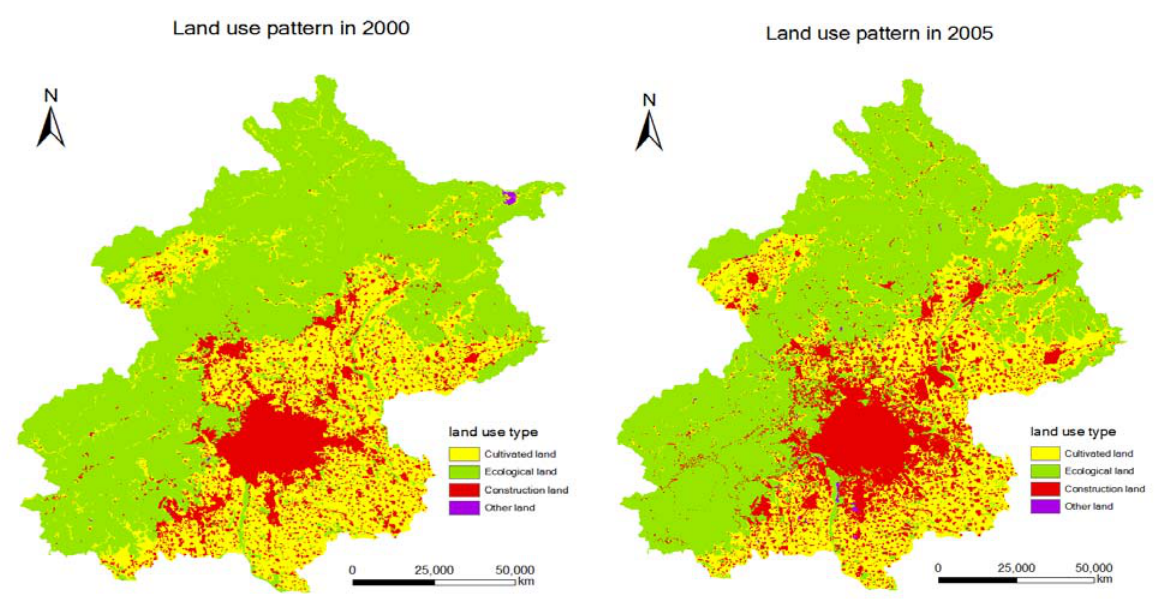
Figure 3. Change of land use pattern from 2000 to 2005 in